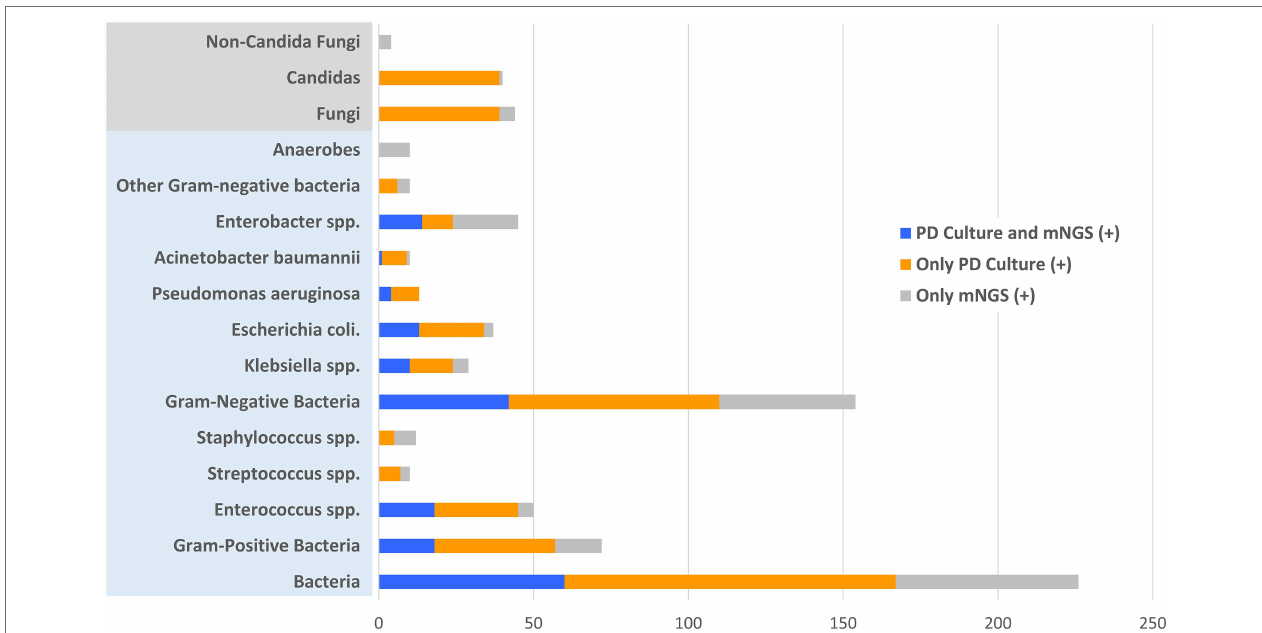
FIGURE 2 | Distribution of positive and matched results of plasma metagenomic next-generation sequencing (mNGS) and peritoneal drainage (PD) culture according to the detected pathogenic strains. X -axis represents the counts of detected pathogenic